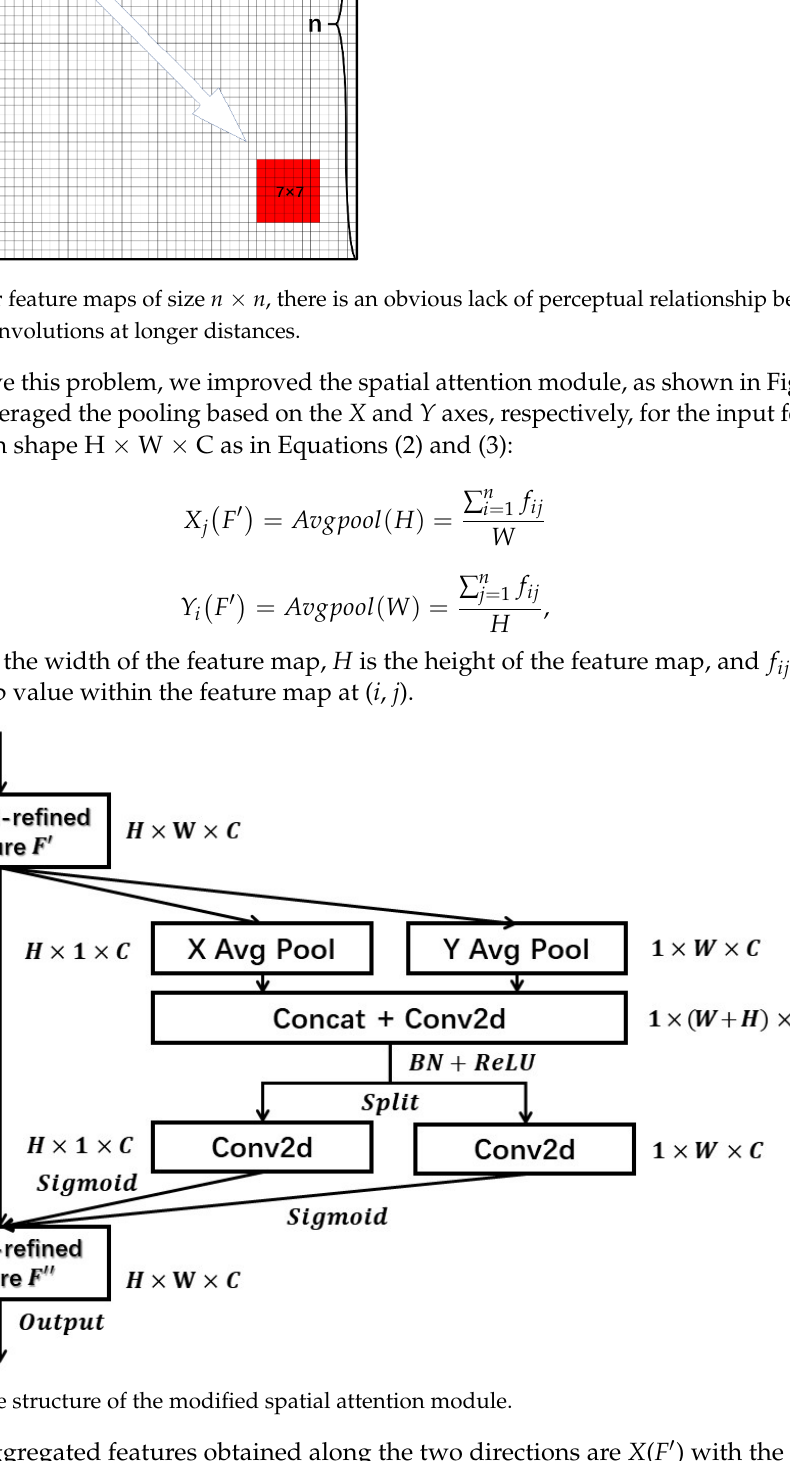
Figure 7. The structure of the modified spatial attention module.